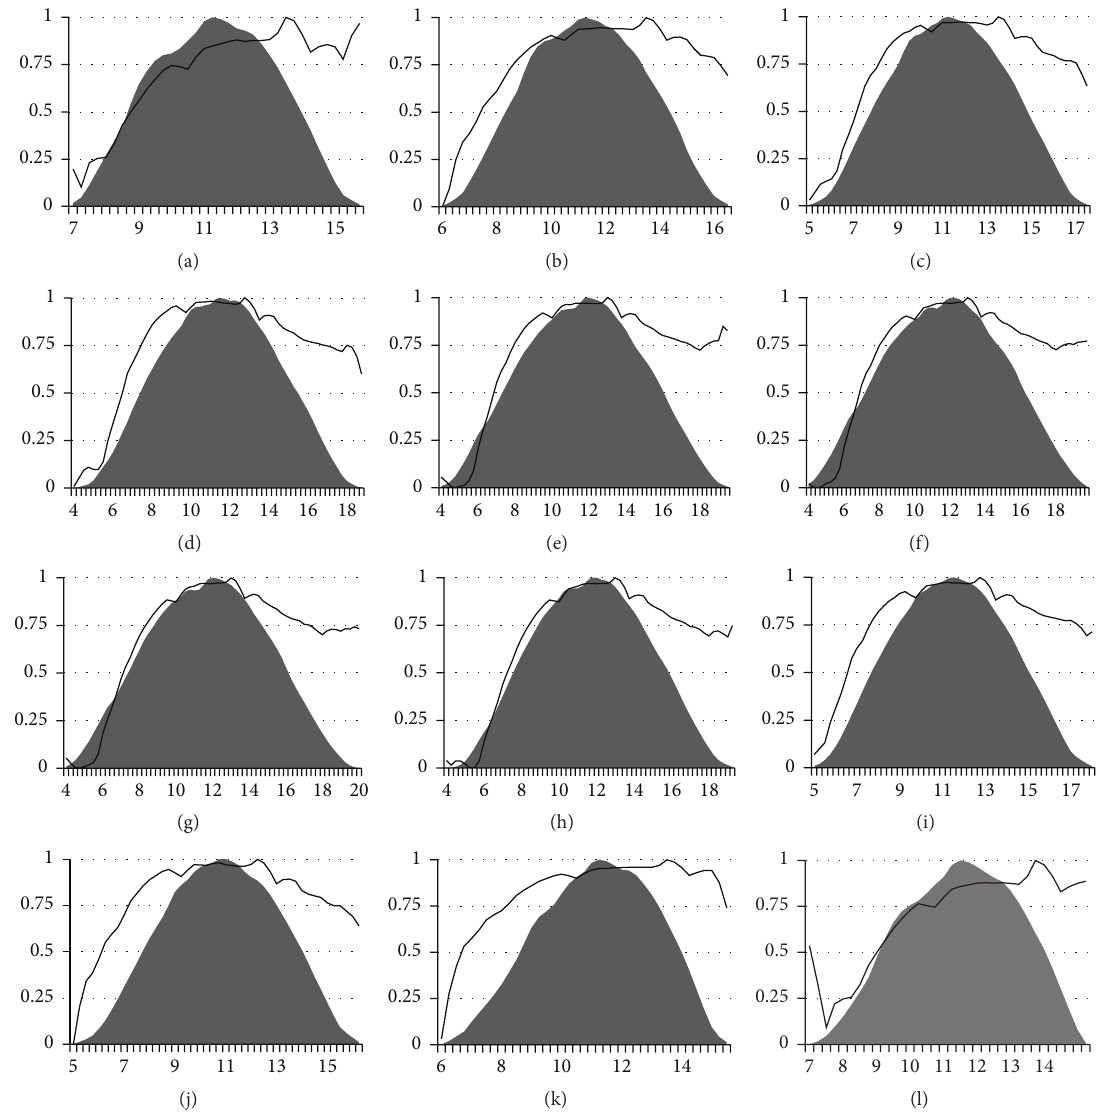
Figure 6: Normalized (0-1) values of irradiation and power load over the course of each month ((a), January). 𝑂𝑋 axis represents the hours of the day and 𝑂𝑌 axis represents normalized values of power load and irradiation, black line: power load, grey area irradiation.